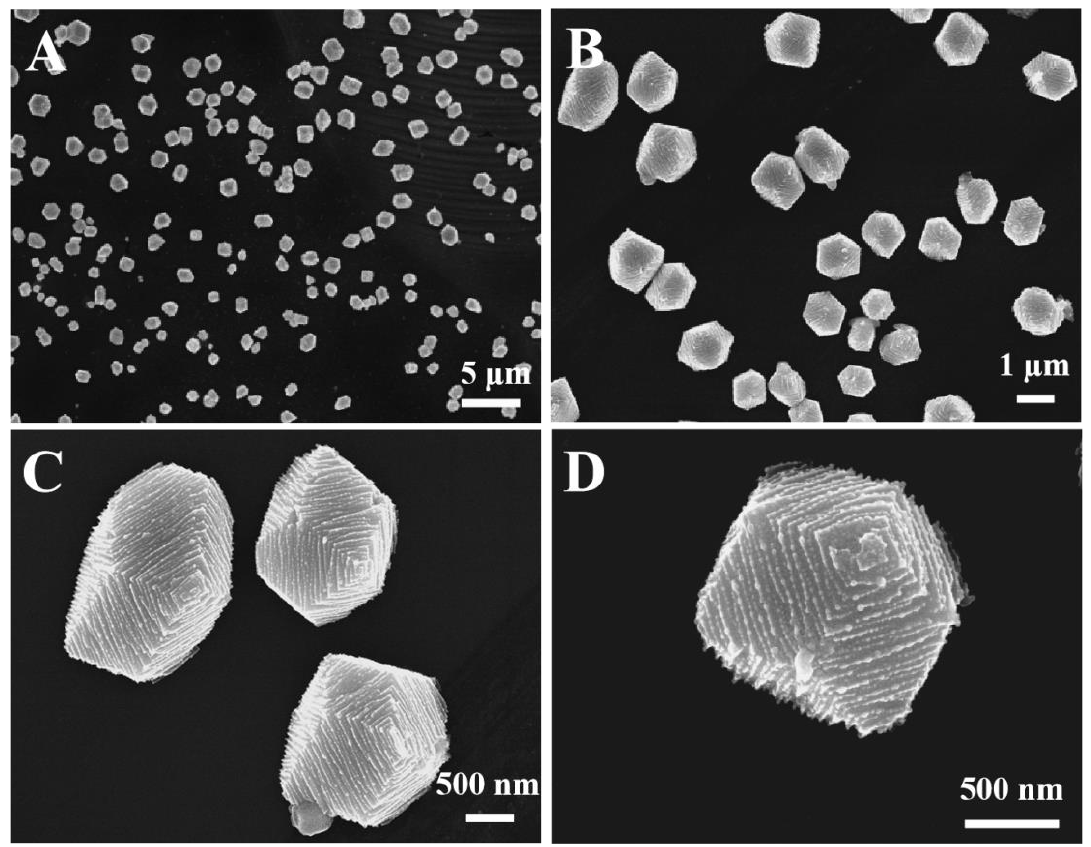
Figure 3. ( A , B ) Low and ( C , D ) high magnification SEM images of HSANs, such as rhombic dodecahedra, obtained at 60 min UV irradiation. Concentration of AgNO 3 precursor: 5 M.